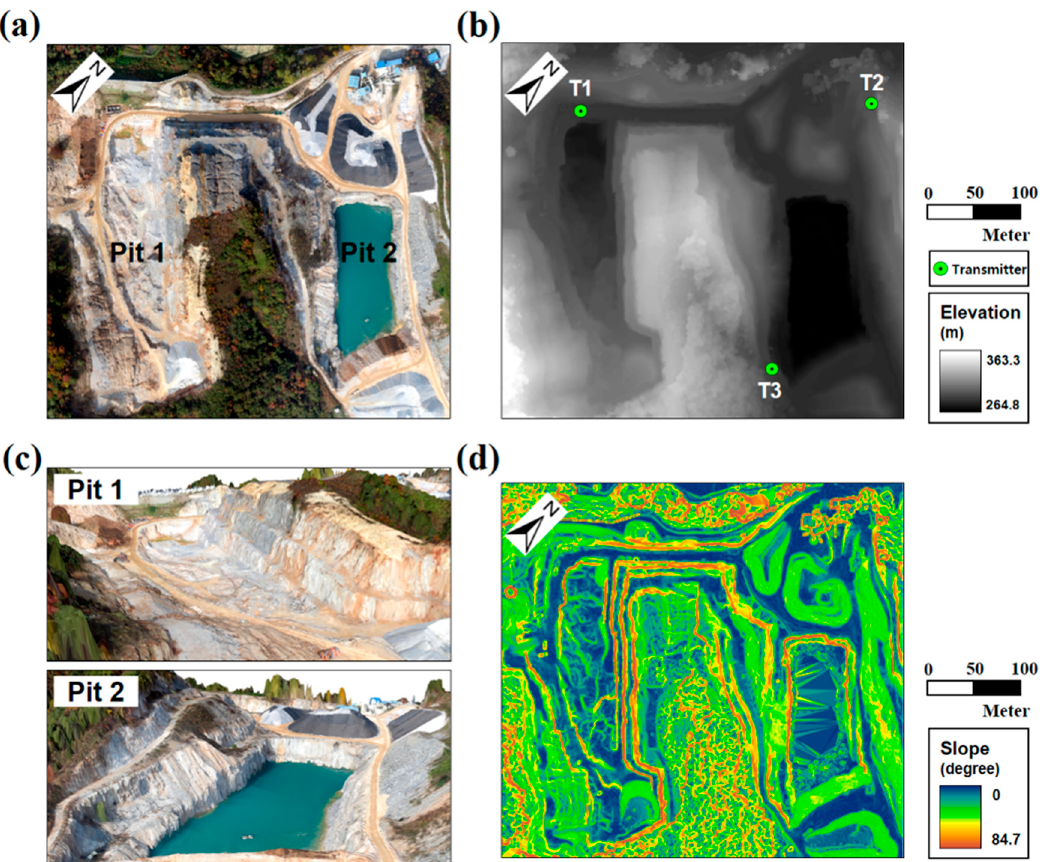
Figure 6. Real-world data sets used to test the algorithm. ( a ) Orthographic image of the open-pit mine obtained using the SenseFly eBee drone. Reference grid is in m and the coordinate system of the image is local transverse Mercator; ( b ) DSM of the study area (resolution = 1 m); ( c ) 3-dimensional views of the study area; and ( d ) distribution of the slope (degrees).